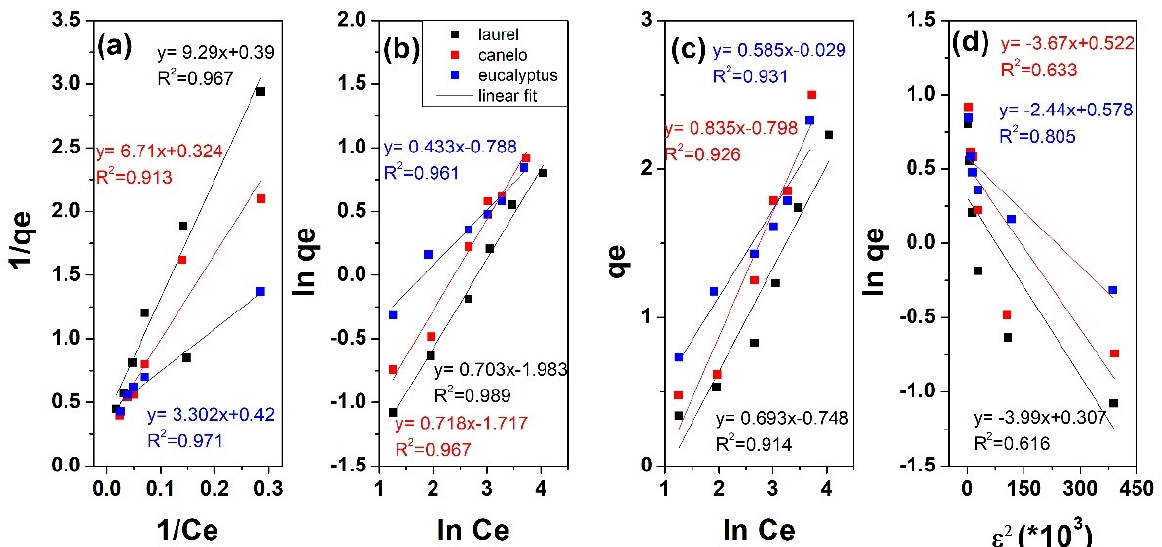
Figure 8. Linear regression analysis of Zn ions adsorption of magnetite modified adsorbents by Langmuir ( a ); Freundlich ( b ); Temkin ( c ) and Dubinin–Radushkevich ( d ), ( ε 2 value multiplied with 10 3 ) models.